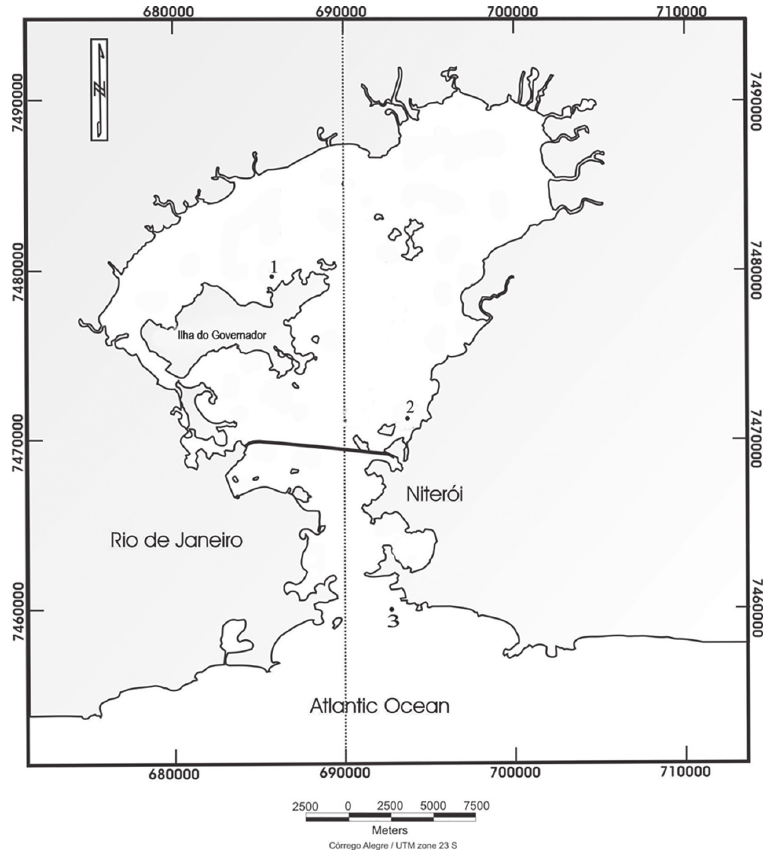
Figure 1 - Guanabara Bay and sample